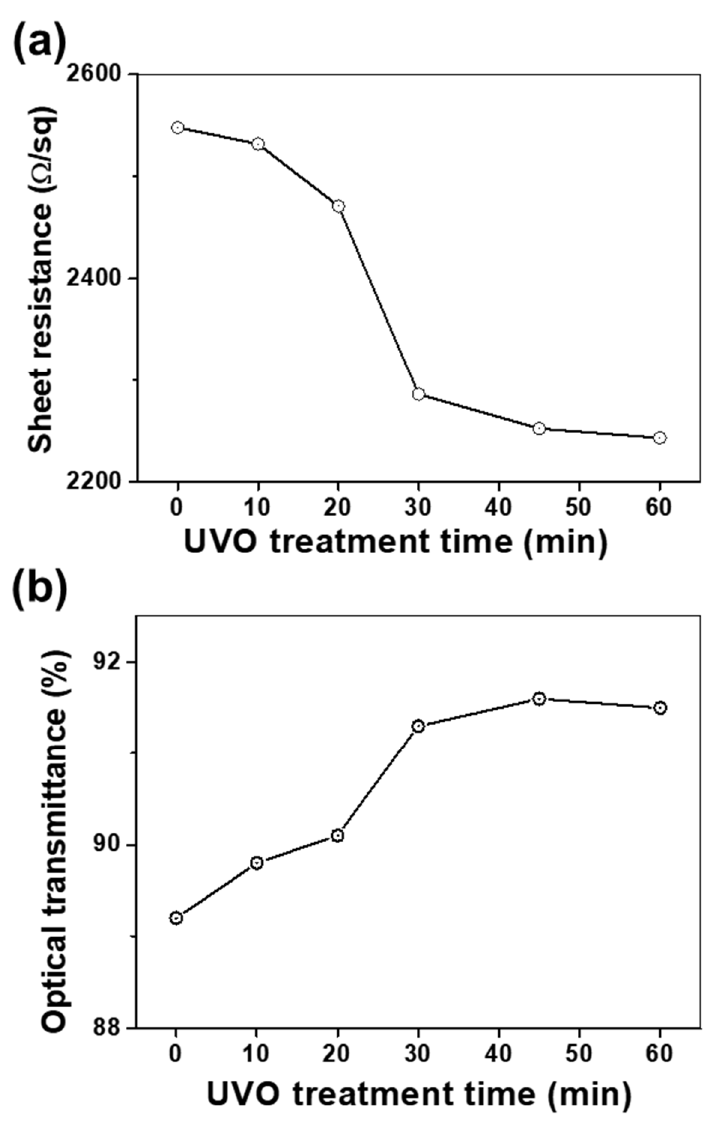
Figure 3. Electrical and optical properties of the RuO 2 NS films. Dependence of ( a ) sheet resistance and ( b ) optical transmittance on the UVO treatment time (min).